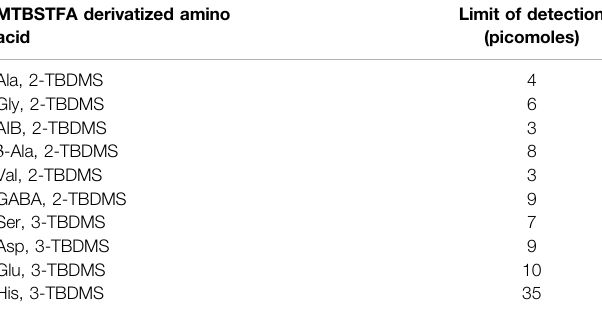
TABLE 3 | Extrapolated limits of detection (LODs) for the derivatized amino acids on the MEMS GC-MS experimental setup. MTBSTFA derivatized amino